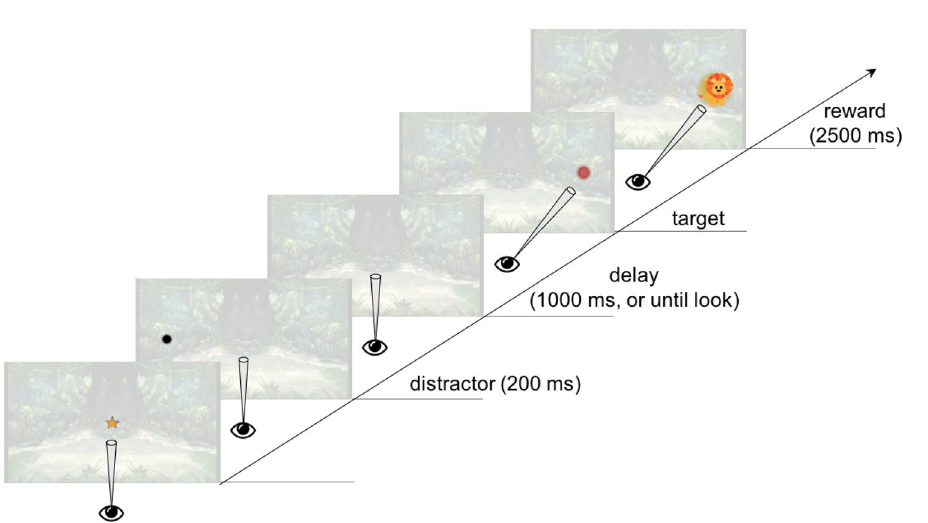
Figure 4. Stimulus sequence for experimental trials in the Anti-Saccade Task. Stimuli drawn to scale. Every trial started with the central fixation stimulus